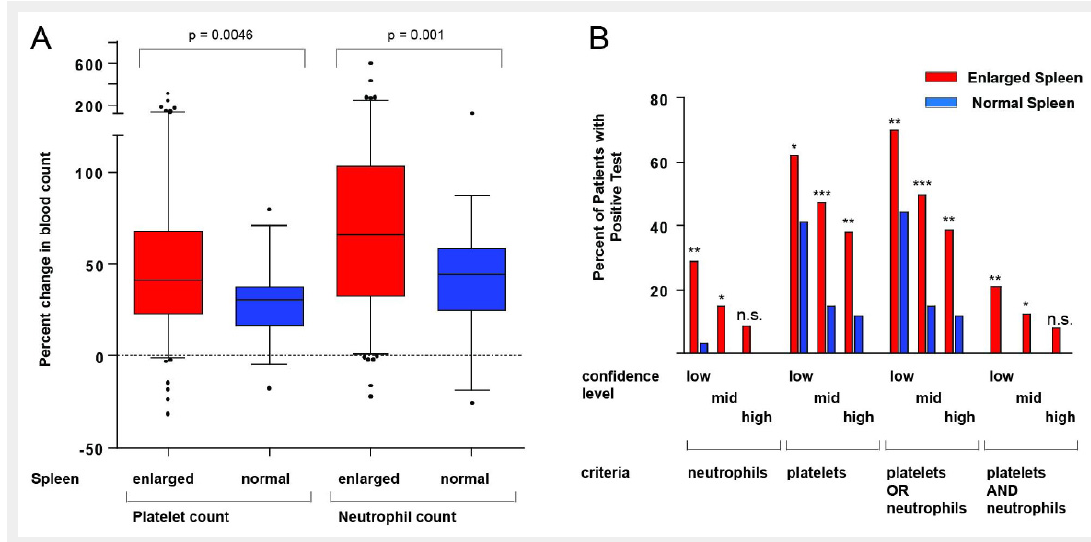
A: Changes in platelet and neutrophil counts in patients according to spleen pole diameter (Mann Whitney U test); box plot and whiskers as described in the legend for figure 1. B: Higher frequency of positive tests in patients with an enlarged spleen compared to patients with a normal size spleen. Different criteria for the evaluation of EST were defined requiring either neutrophils, platelets, one of each (“platelets OR neutrophils”) or both (“platelets AND neutrophils”) to be above the respective cutoff. Limits of low, intermediate ("mid") and high confidence of the test were defined: For platelets an increase of 30%, 40% or 50% respectively was chosen. For neutrophil counts these values were 60%, 100% or 150% respectively. Significance was calculated using Fisher’s exact